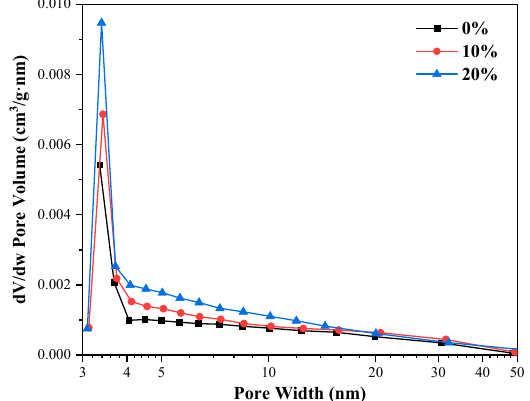
Figure 10. Pore diameter distribution of C 3 S-C 3 A paste.